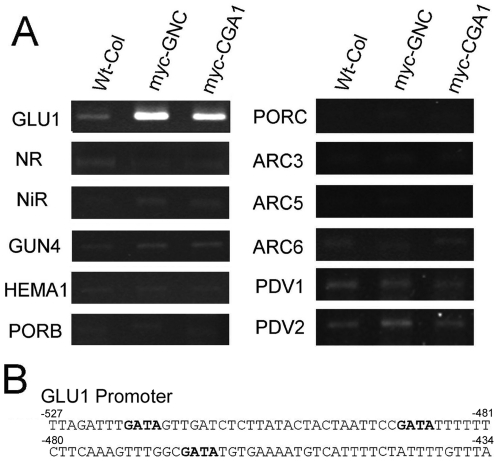
Chromatin immunnoprecipitation (ChIP) of myc-tagged GNC and CGA1 protein indicates interaction with the GLU1 promoter.A) PCR of promoter regions containing GATA sites from suspected candidate genes following precipation with c-myc antibody using extracts from wild type plants and transgenics lines expressing myc-tagged GNC or CGA1. B) Region of the GLU promoter containing mutiple GATA sites suspected to be binding sites for GNC and CGA1 proteins.